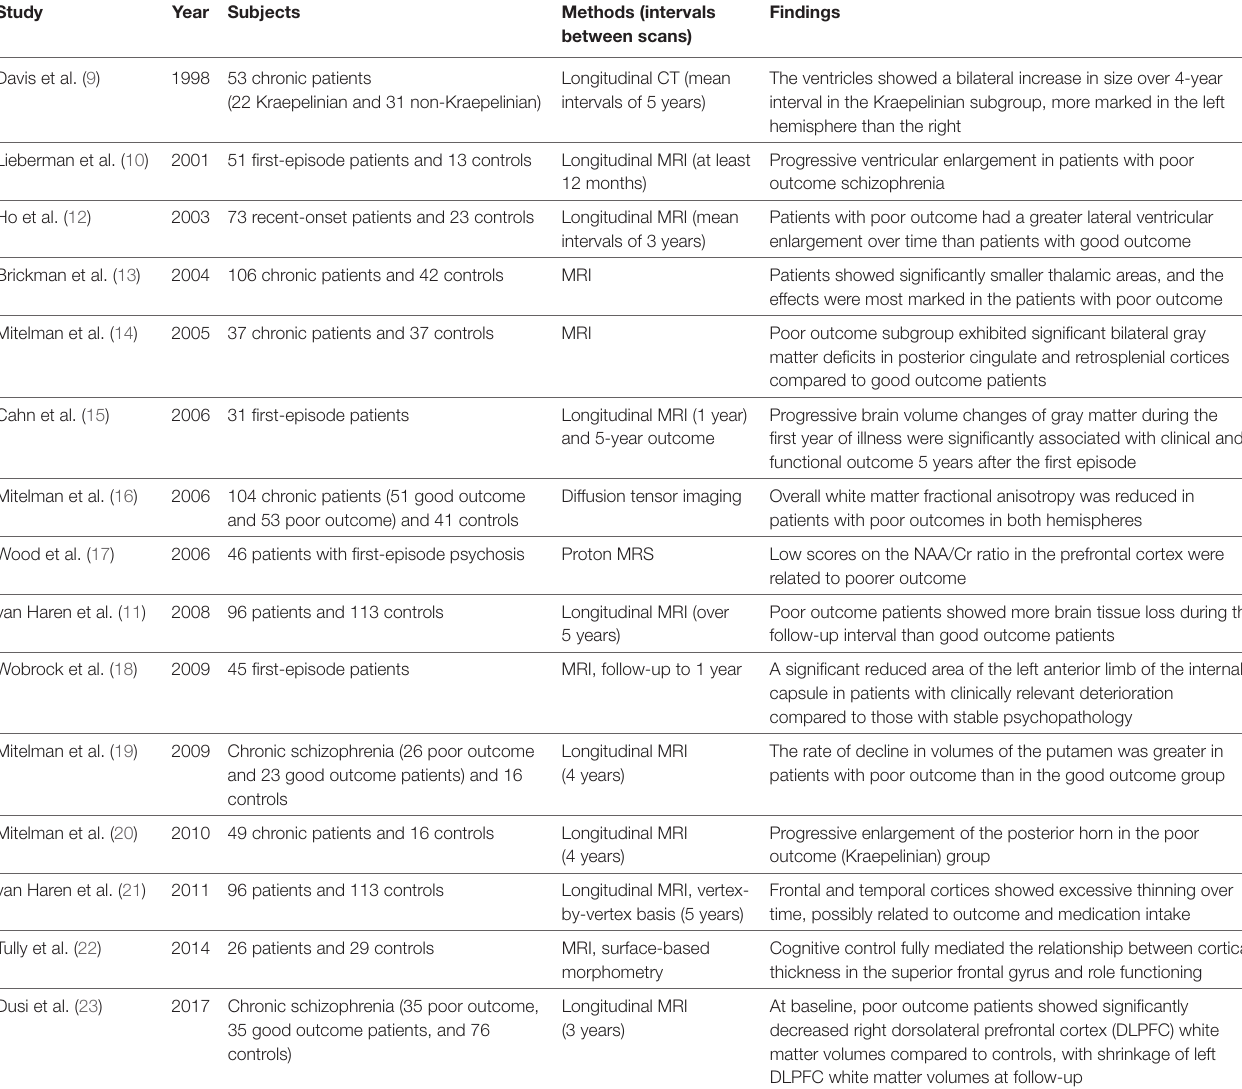
TABLe 1 | Morphological changes in the brain related to the functional outcome in schizophrenia